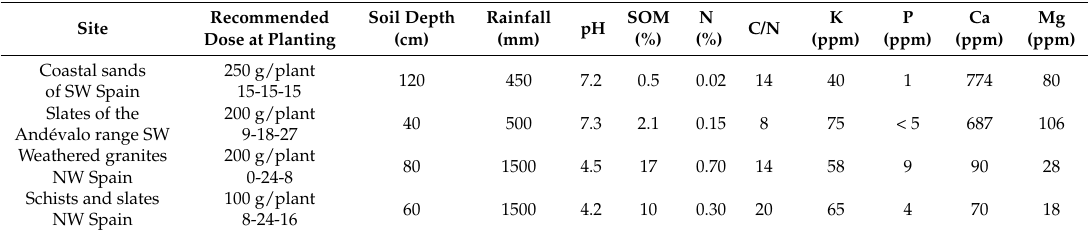
Table 1. Recommended dose of fertilizer for Eucalyptus globulus in Spain and soil properties for each site (reported in the literature with